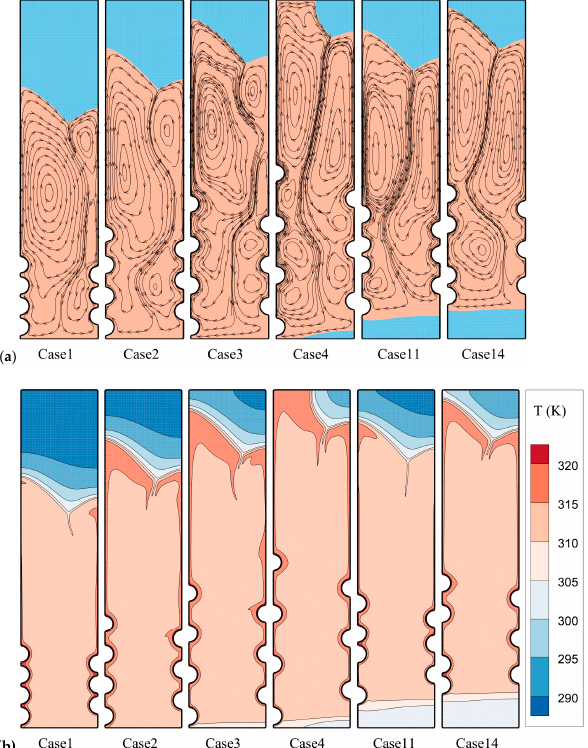
Figure 10. The melting behavior of the unit after four hours: ( a ) The streamlines and melting field; ( b ) the isotherms. 5. Conclusions A geometrical design of an LHTES unit heated by HTF tubes was systematically investigated. The model of LHTES consisted of seven HTF tubes where five variables